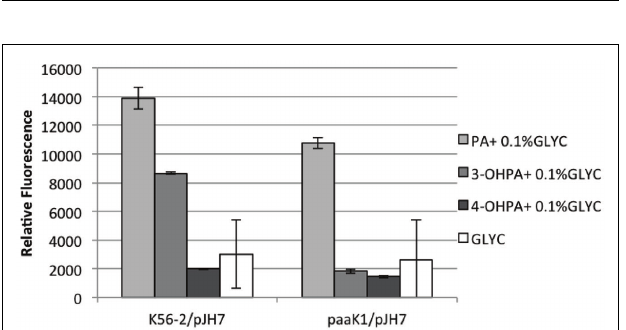
FIGURE 3 | B. cenocepacia K56-2 reporter activity assays. PA pathway induction in B. cenocepacia K56-2 (wild type) measured as relative fluorescence at 12h. Strains were grown in M9 minimal media with PA, 3-OHPA, or 4-OHPA (plus 0.1% glycerol) or 0.2% glycerol. pJH7, paaA promoter reporter; pJH8, paaH promoter reporter; pJH6, paaZ promoter reporter; pJH1, positive control; pJH2, negative control. Error bars represent the SD of three replicates.